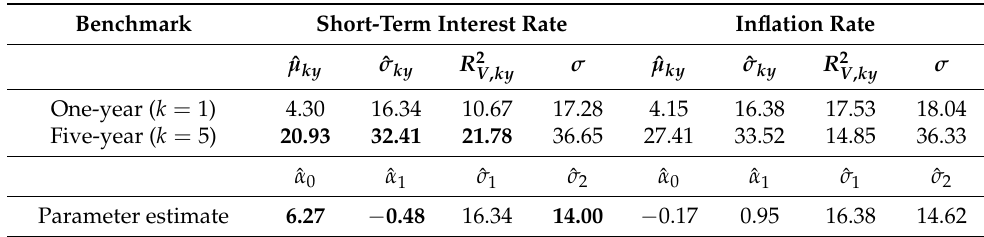
Table A1. Estimated parameters of the econometric model under the short-term interest rate bench- mark or the inflation benchmark based on common predictive variables (earnings and spread) for one- and five-year horizons. Changes (compared to Table 7) are provided in boldface. See also the notes in Table 7.